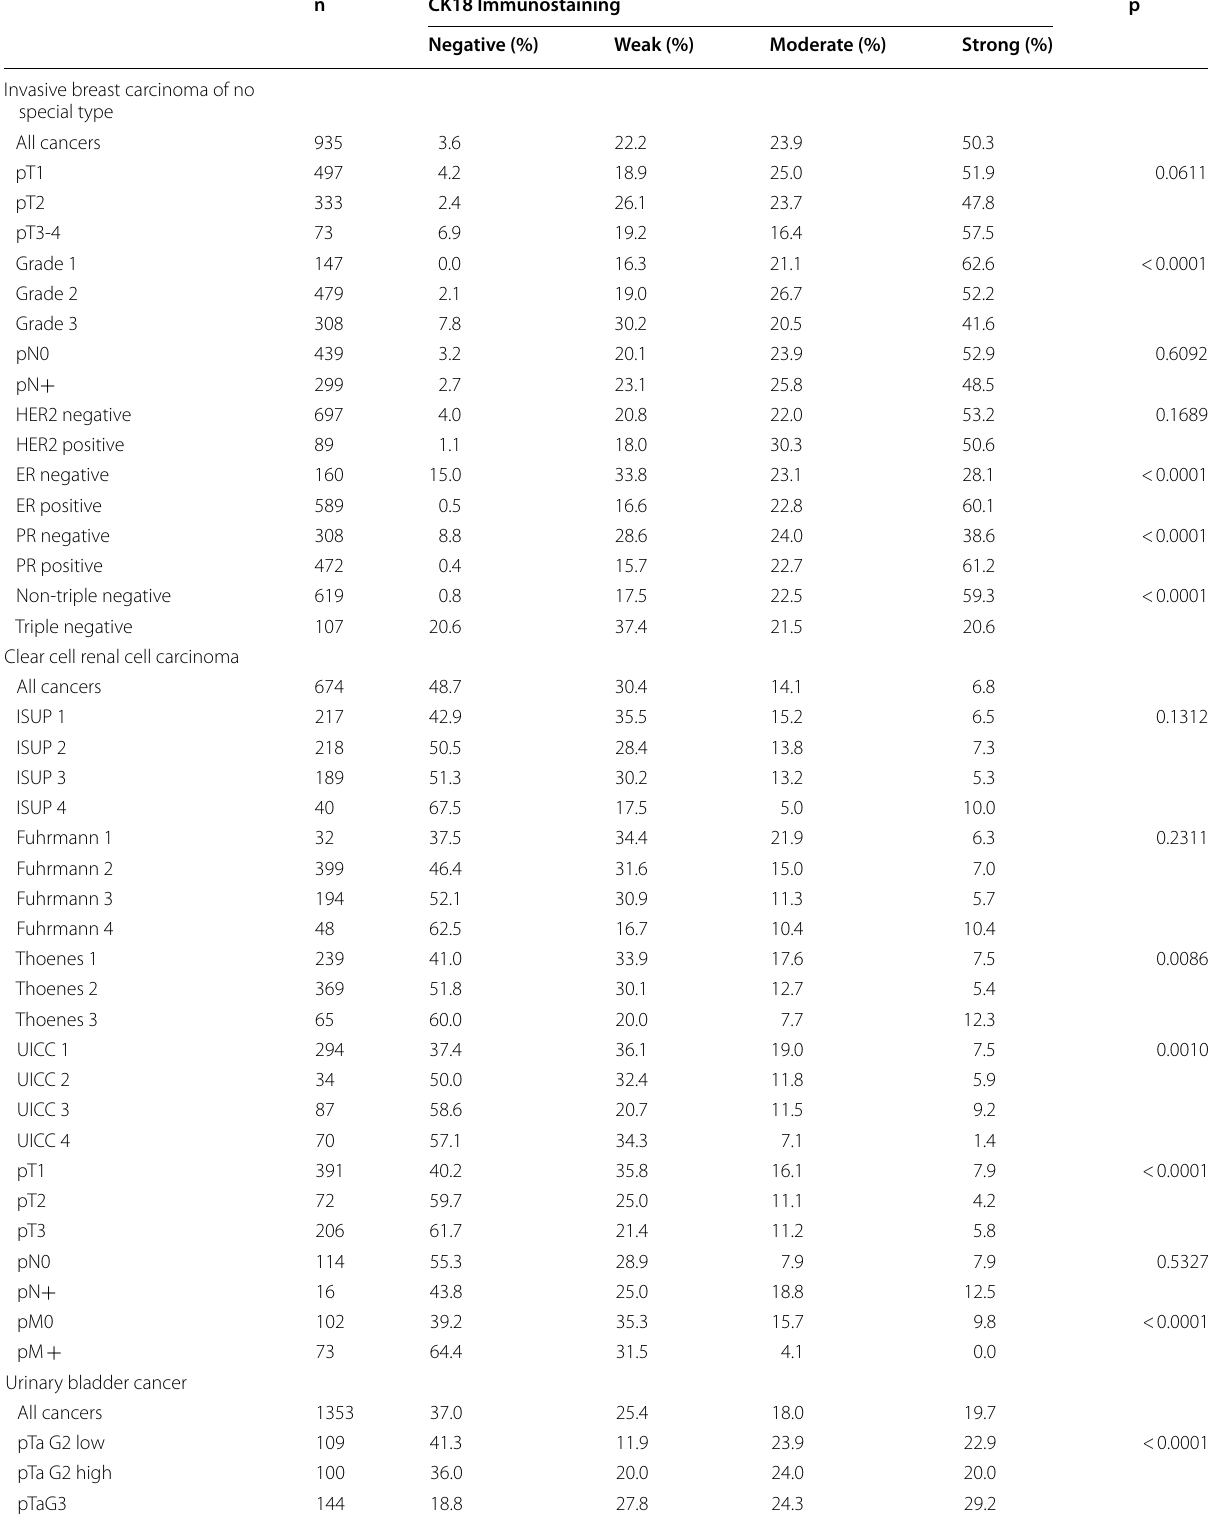
Table 2 Cytokeratin 18 immunostaining and tumor phenotype n CK18 Immunostaining p Negative (%) Weak (%) Moderate (%) Strong